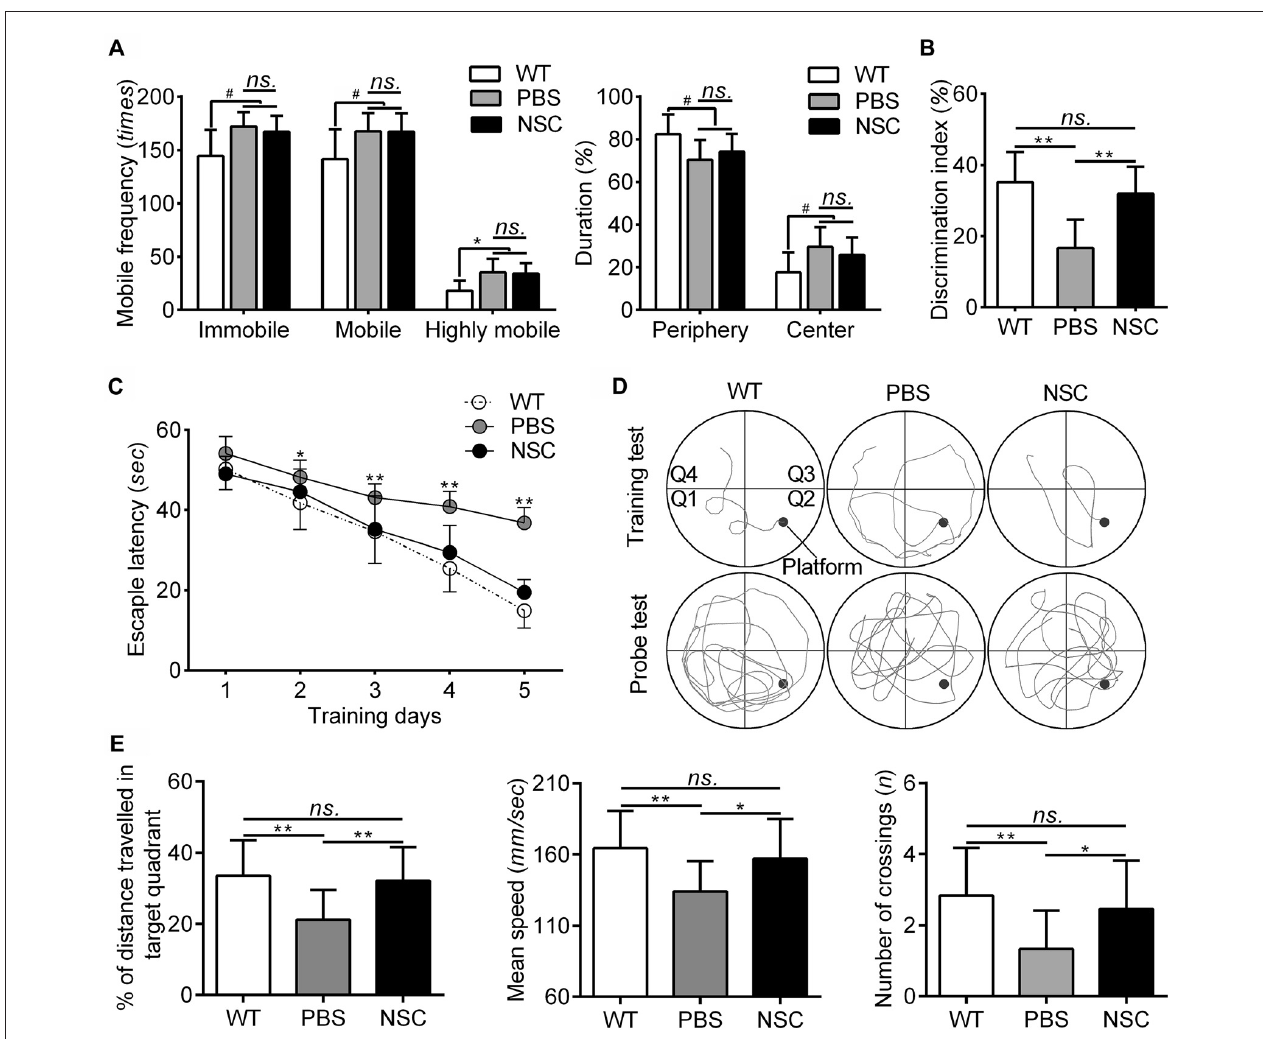
FIGURE 2 | hNSCs rescued recognition, learning and memory function but not anxiety level in APP/PS1 mice. (A) Analysis of open field test (OFT) tests. There was no significant difference in frequencies of mobile, immobile and highly mobile states, as well as % of duration in periphery and central zones between the PBS and NSC group ( ns. = p > 0.05), # p < 0.05 vs. wild-type (WT) mice. (B) There was no difference in discrimination index (DI) between the WT and NSC group ( ns. = p > 0.05), ∗∗ p < 0.01 vs. the PBS group. (C) Escape latencies in five training days of the morris water maze (MWM). Significant interactions were found for the latency from training day 2 ( ∗ p < 0.05; ∗∗ p < 0.01), where NSC group mice decreased the latency to the hidden platform. No significant difference in latencies was found between the NSC and WT group ( ns. = p > 0.05). (D) Representative training (5th day) and probe traces of mice in three groups. (E) Analysis of the